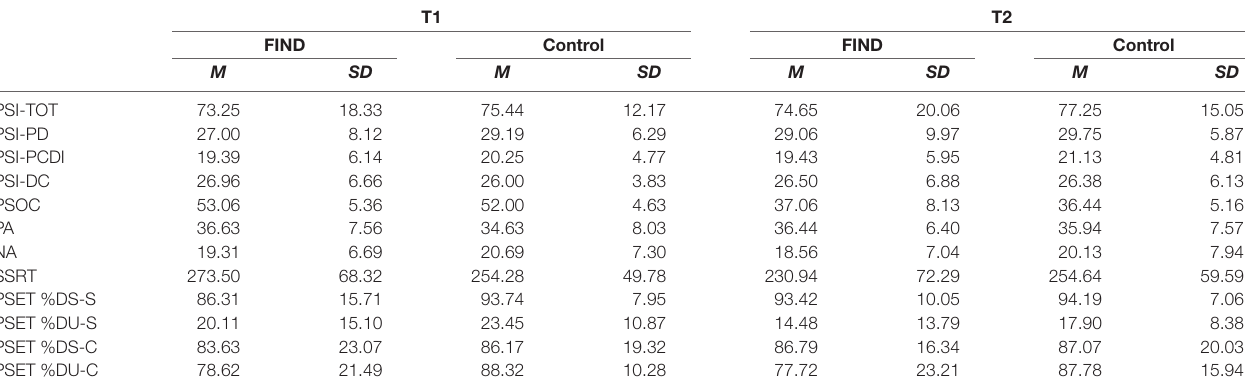
TABLE 2 | Means and SDs among variables gathered by time and group. T1 T2 FIND Control FIND Control